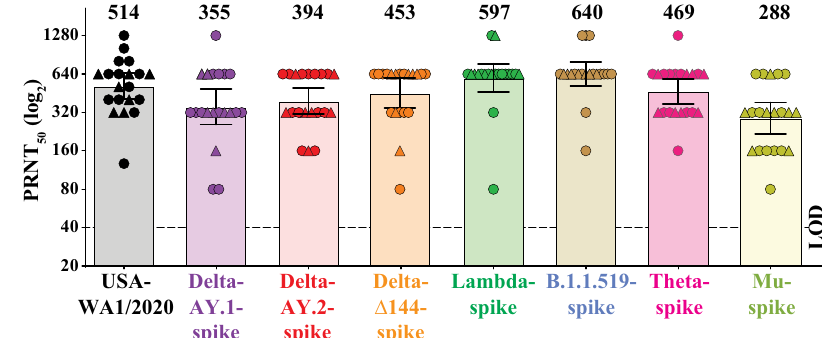
Fig. 1 BNT162b2 vaccine-elicited neutralization of SARS-CoV-2 variants. The plot presents the PRNT 50 titers of 20 human sera (drawn 2 or 4 weeks after two 30-µg doses of BNT162b2, spaced three weeks apart) against USA-WA1/2020 isolate and its chimeric viruses bearing distinct variant spikes. Serum samples obtained at 2 weeks or 4 weeks are represented by circles and triangles, respectively. Individual PRNT 50 values are presented in Supplementary Table 1. Each data point represents the geometric mean PRNT 50 against the indicated virus obtained with a serum specimen. The PRNT 50 values against each variant were determined in duplicate assays of one experiment for each variant; the PRNT 50 values for USA-WA1/2020 were pooled from three independent experiments; and the geometric means were calculated ( n = 20). The values represent the geometric means with 95% con fi dence intervals. The numbers above the bars indicate geometric mean titers. The limit of detection (LOD) of the PRNT assay is 1:40 and indicated by a dashed line. Statistical analysis was performed using the two-tailed Wilcoxon matched-pairs signed-rank test. The statistical signi fi cances of the differences between geometric mean titers in the USA-WA1/2020 neutralization assay and in each variant virus neutralization assay with the same serum samples are as follows: P = 0.0253 for Delta-AY.1-spike; P = 0.0253 for Delta-AY.2-spike; P = 0.260 for Delta- Δ 144-spike; P = 0.156 for Lambda-spike ; P = 0.018 for B.1.1.519-spike; P = 0.328 for Theta- spike; and P < 0.001 for